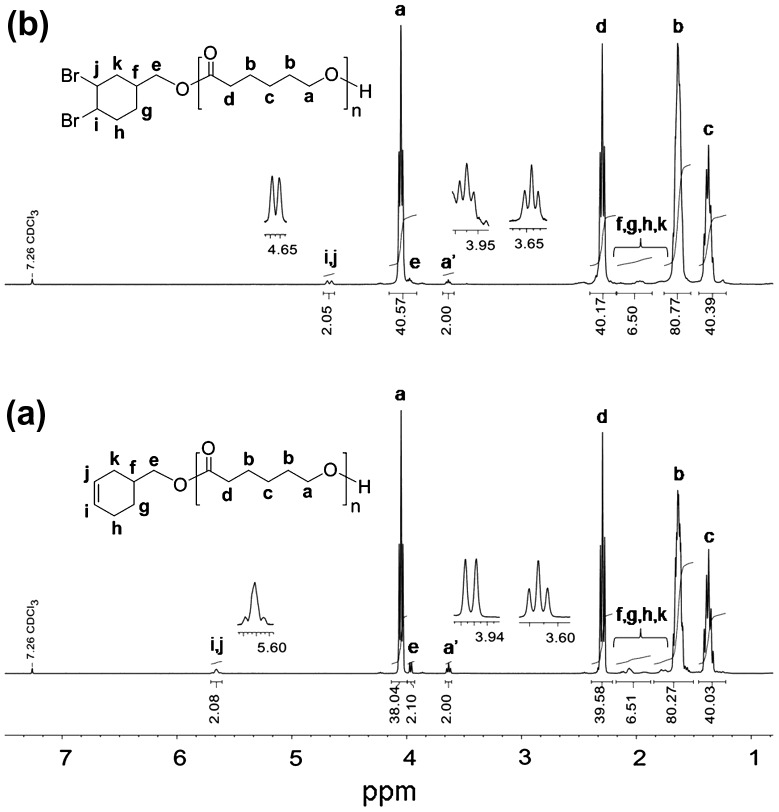

1H NMR spectra of PCL-CH (a) and PCL-(Br)2 (b) in CDCl3.